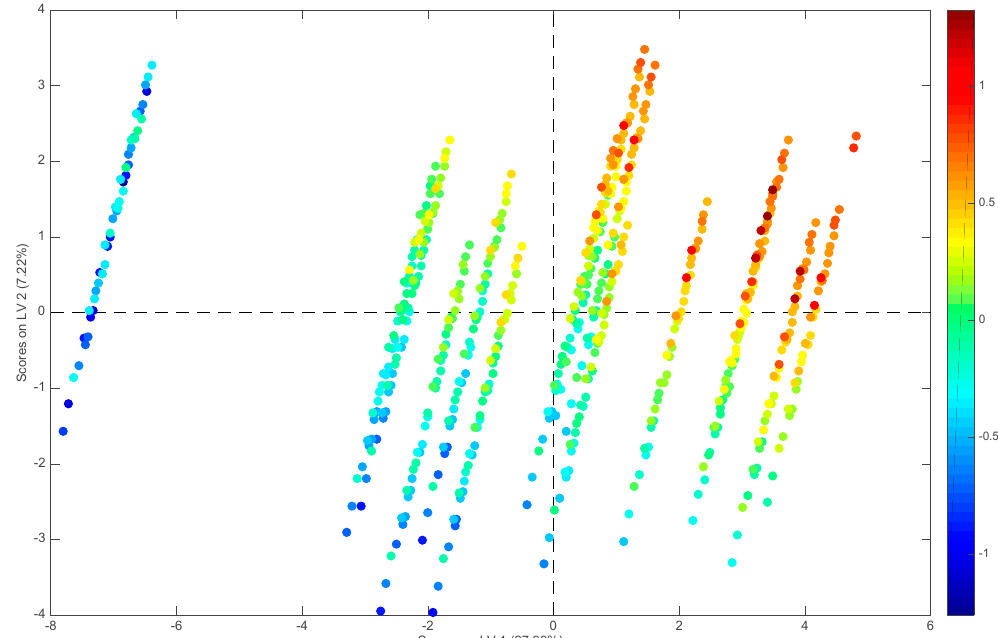
Figure 2. PLS model built on the reduced set of 29 predictors selected by GA: scores plot of the training samples. The points are colored according to their values of log k. Molecules 2020 , 25 , x FOR PEER REVIEW